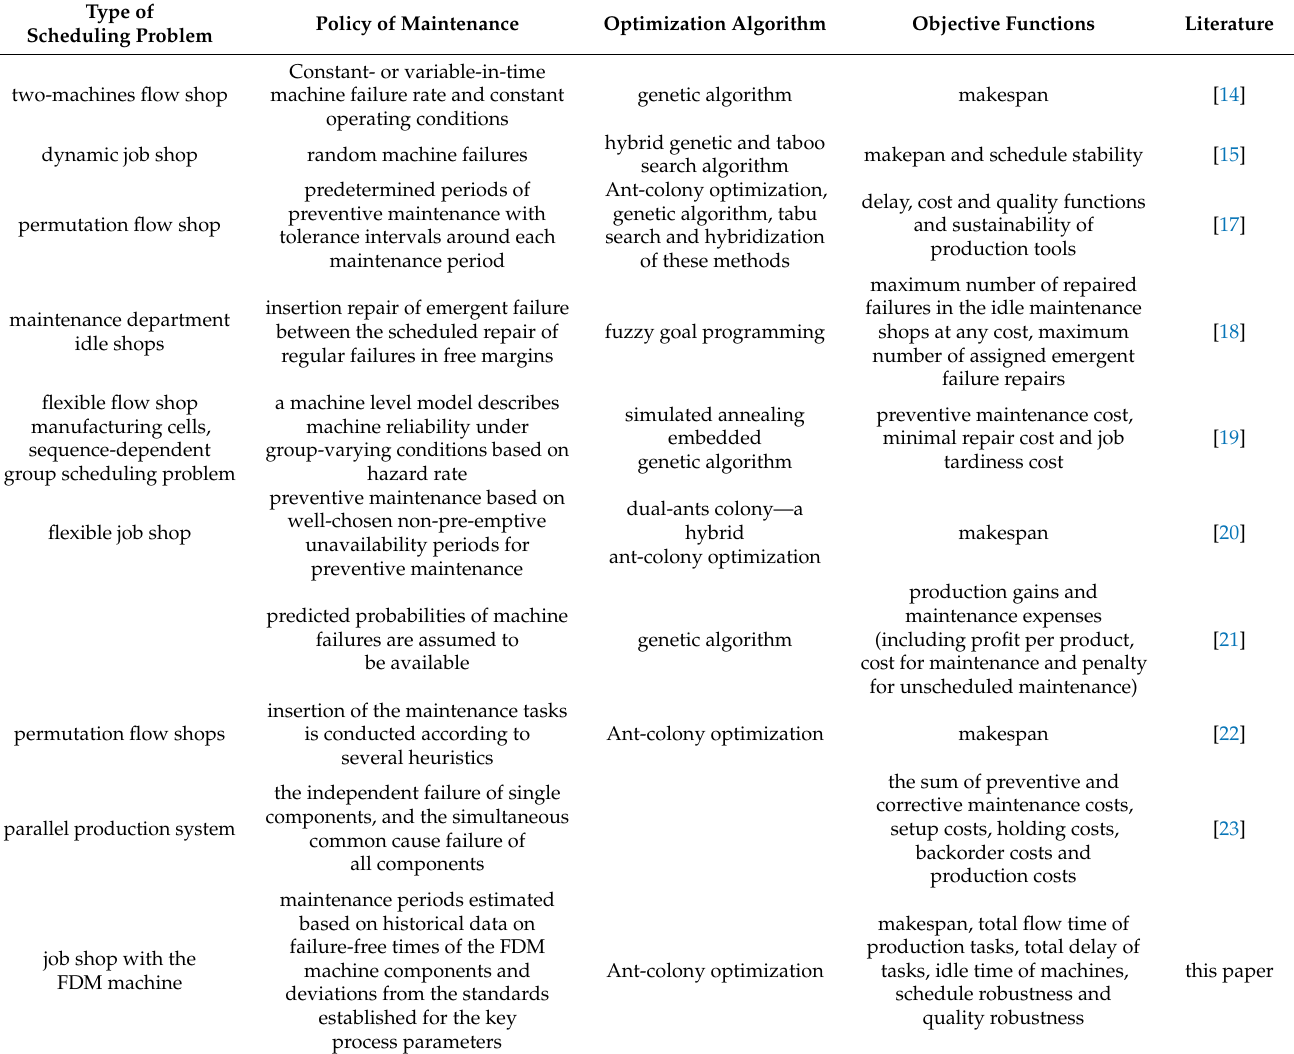
Table 1. The literature review on joint production and maintenance